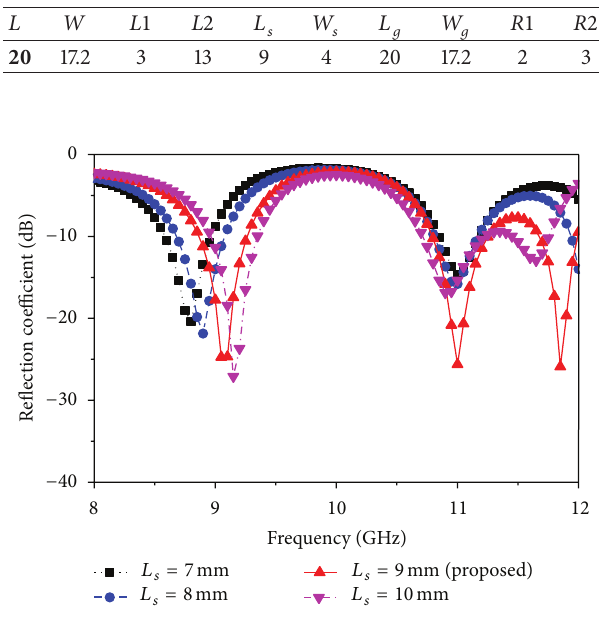
Figure 3: Simulated reflection coefficient for different values of 𝐿 𝑠 (other parameters: 𝐿 = 20 mm, 𝑊 = 17.2 mm, 𝐿1 = 3 mm, 𝐿2 = = 4 mm, 𝐿 = 20 mm, 𝑊 = 17.2 mm, 𝑅1 = 2 mm, 13 mm, 𝑊 𝑠 𝑔 𝑔 𝑌 = 10, 8.6 ). 𝑅2 = 3 mm, 𝑋 𝑓 , 𝑓